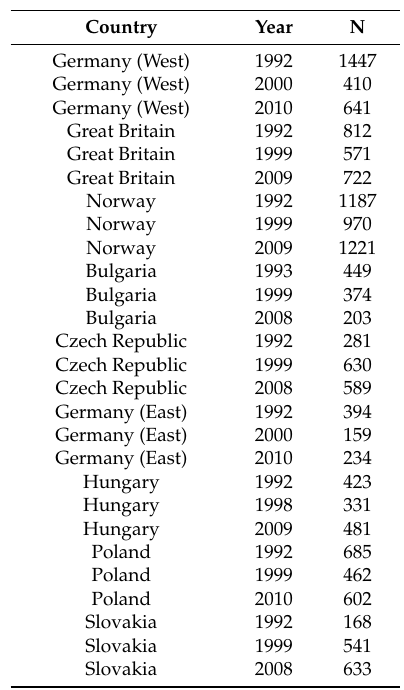
Table A1. Overview of Countries and Sample Size by Survey Year.